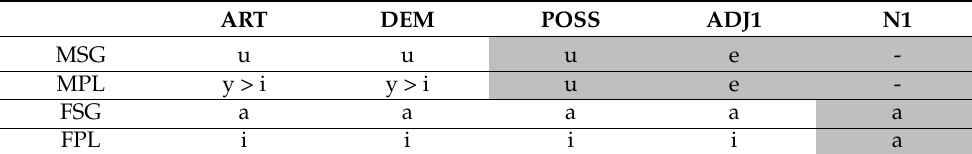
Table 6. Inflectional